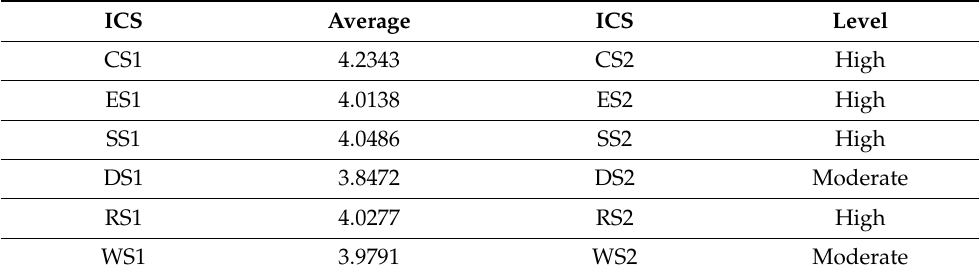
Table 4. Descriptive statistics for personal and professional growth by interpersonal communication style (ICS). ICS Average ICS Level CS1 4.2343 CS2 4.0138